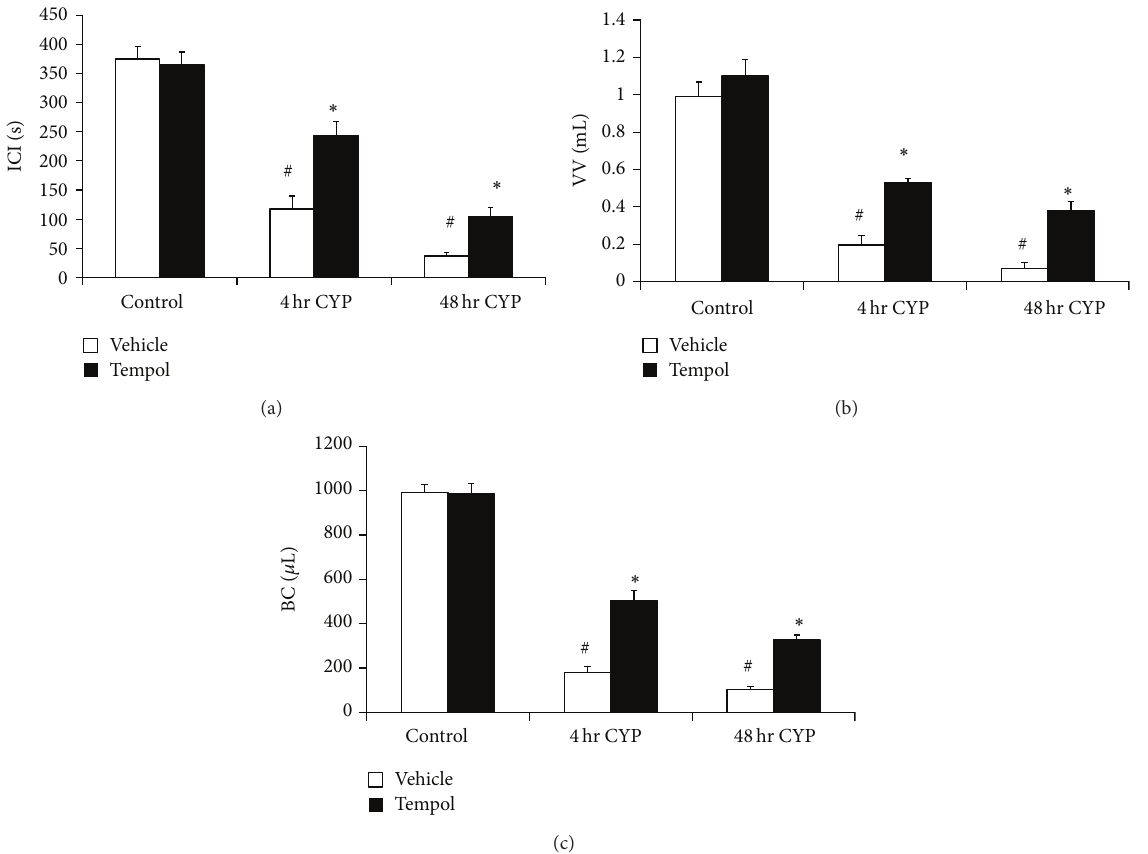
Figure 5: Summary histograms of the effects of Tempol (1mM) on intercontraction interval (ICI; s), bladder capacity (BC; 𝜇 L), and void volume (VV; mL) in CYP-treated (4hr; 48hr) rats. Tempol in the drinking water significantly ( 𝑃 ≤ 0.01 ) increased ICI (a), VV (b), and BC (c) in CYP-treated (4hr and 48 hr) rats. Tempol was without effect in control (no CYP treatment) rats. # 𝑃 ≤ 0.01 compared to control + vehicle (between-group difference); ∗ 𝑃 ≤ 0.01 compared to 4hr or 48hr CYP + vehicle (within-group difference). Sample sizes are 𝑛 = 6 in control and treatment